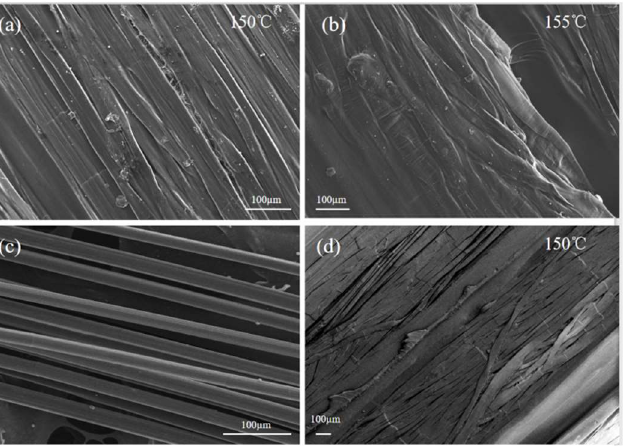
Figure 8. SEM images of the CFSRC’s surface: Longitudinal section of tested samples printed at ( a ) 150 °C and ( b ) 155 °C; ( c ) initial UHMWPE fibers and ( d ) those etched with dimethylbenzene.